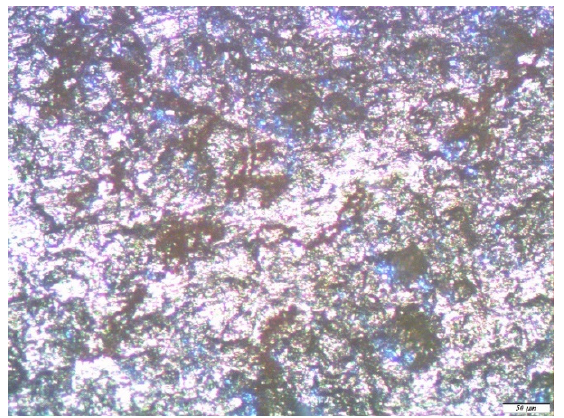
corrosion products.